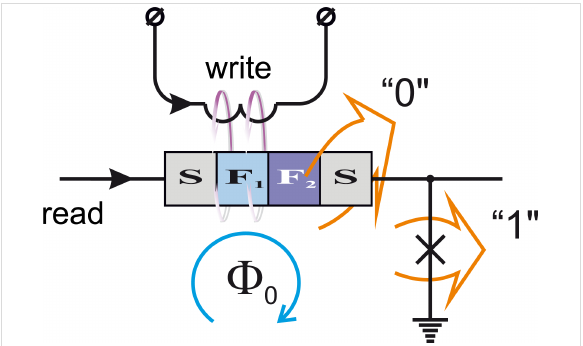
Figure 14: Principal scheme of implementation of write and read oper- ations in a circuit based on MJJ